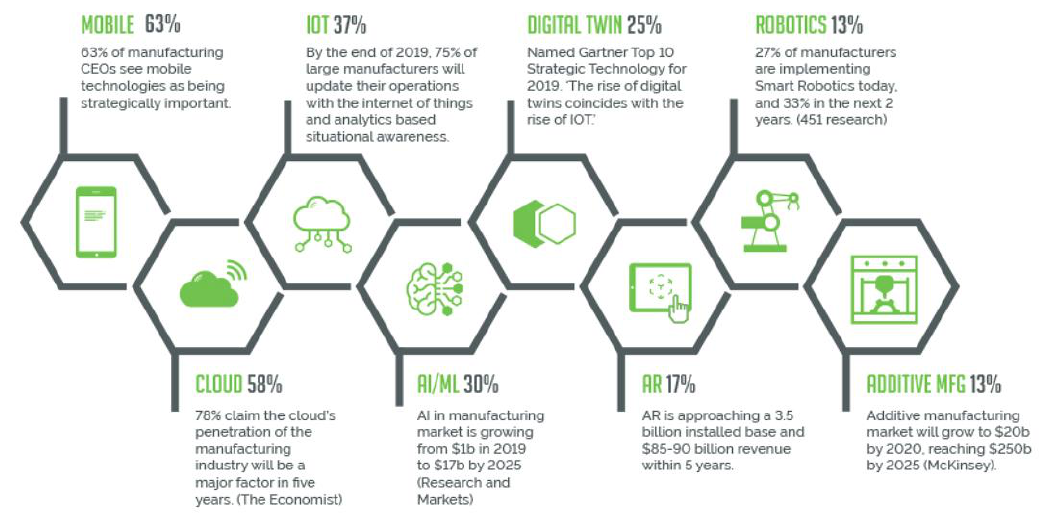
Figure 7. Technology tools for digital transformation